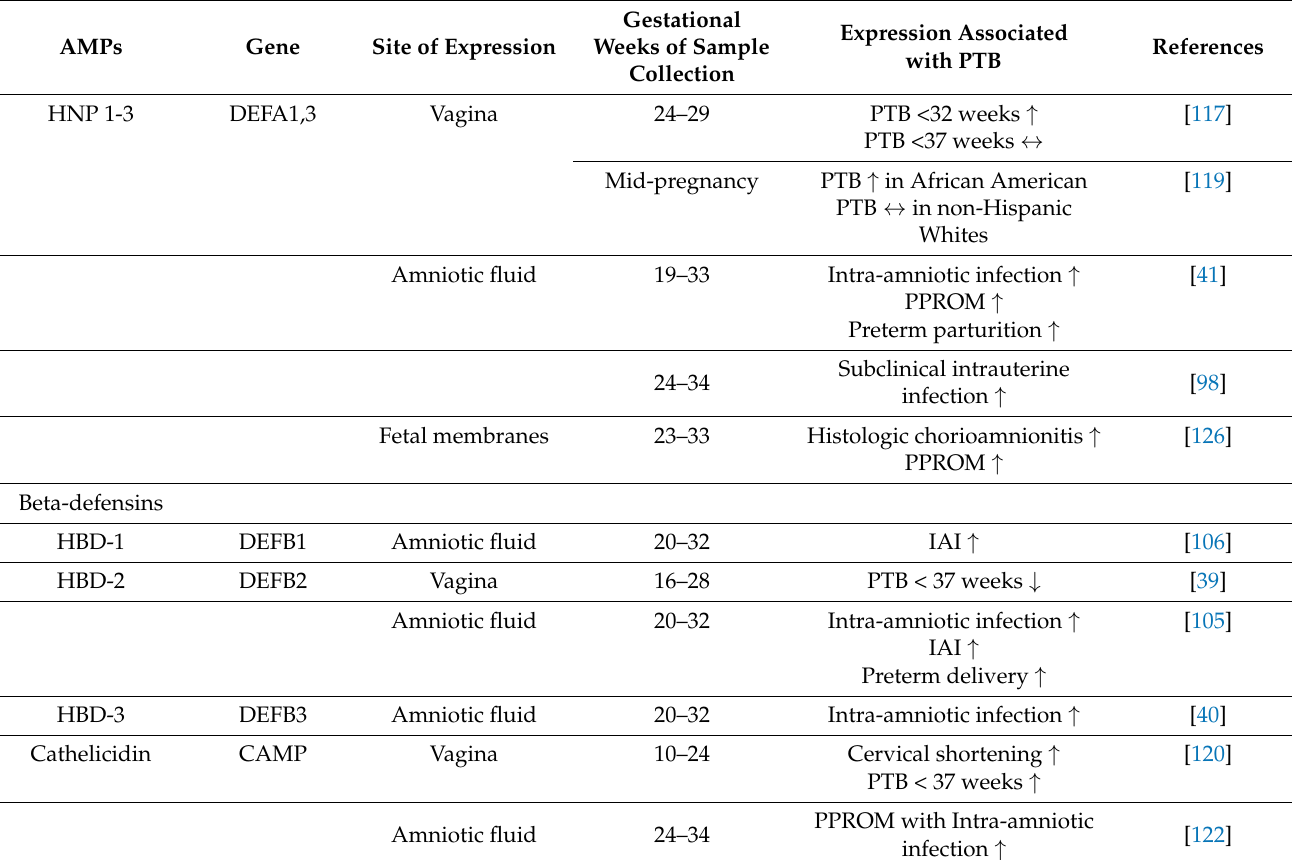
Table 1. Summary of the expression of AMPs associated with preterm